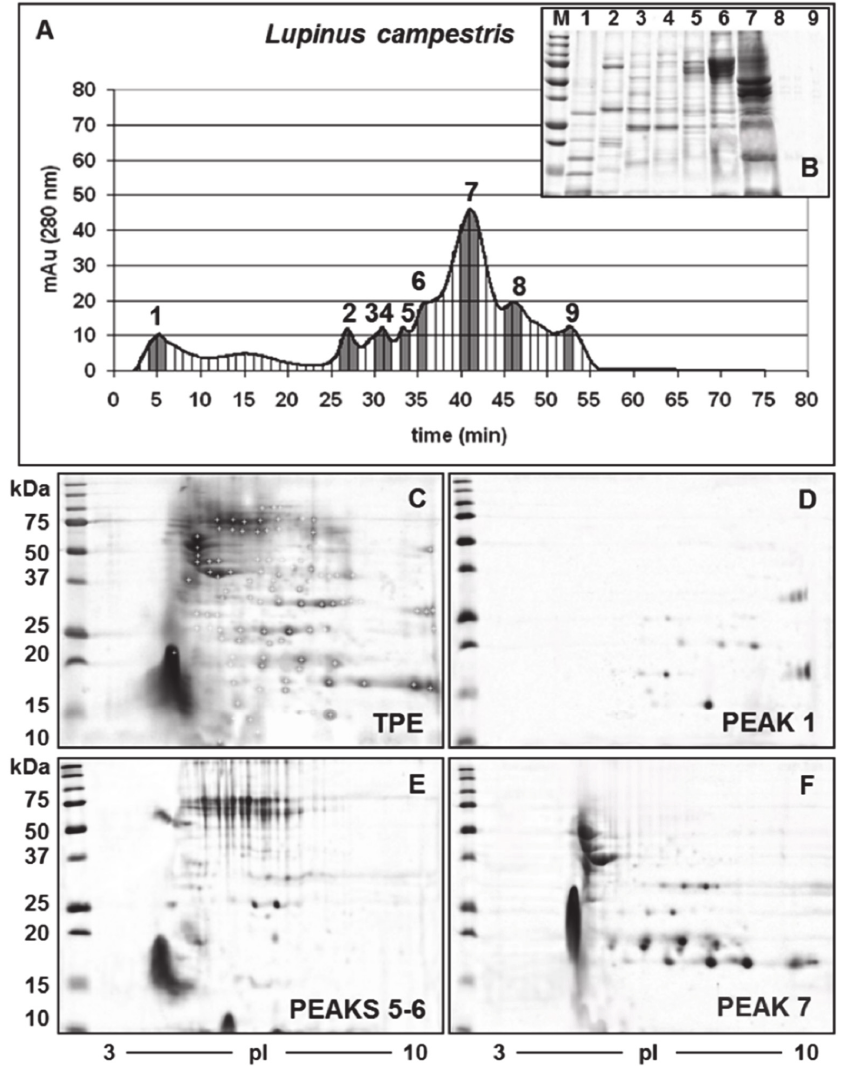
Figure 2. Electrophoretic gels of proteins of L. campestris . ( A ) HPLC chromatogram of the total protein extract (TPE) on a MonoQ column. ( B ) SDS ‐ PAGE of the preparative HPLC collected fractions. ( C ) Proteome reference map of reduced TPE where in total 100 spots were detected. ( D ) Two ‐ dimensional map of purified γ‐ conglutin. ( E ) Two ‐ dimensional map of purified β‐ conglutin. ( F ) Two ‐ dimensional map of purified α‐ conglutin. The standard marker (Precision Plus Protein) is indicated in kDa on the left.